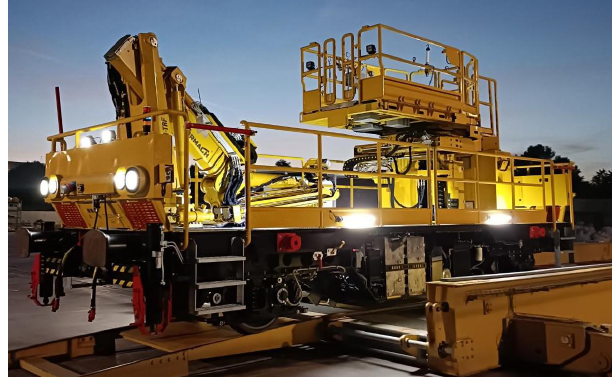
Figure 2. APLA100-E vehicle. Table 1. Main characteristics of the APLA100-E